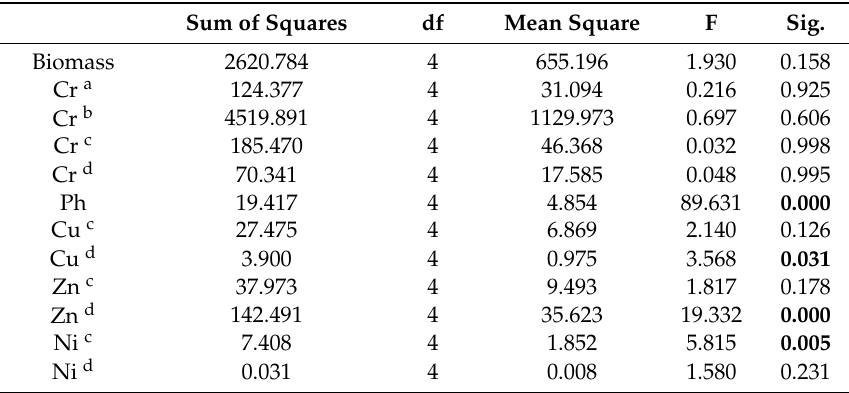
Table 5. Analysis of variance (ANOVA)